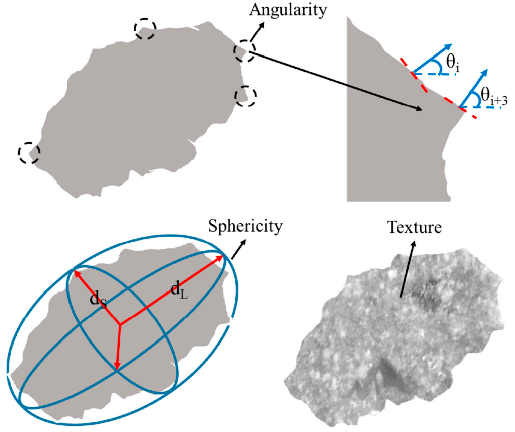
Figure 3. The morphological characteristics of aggregates.